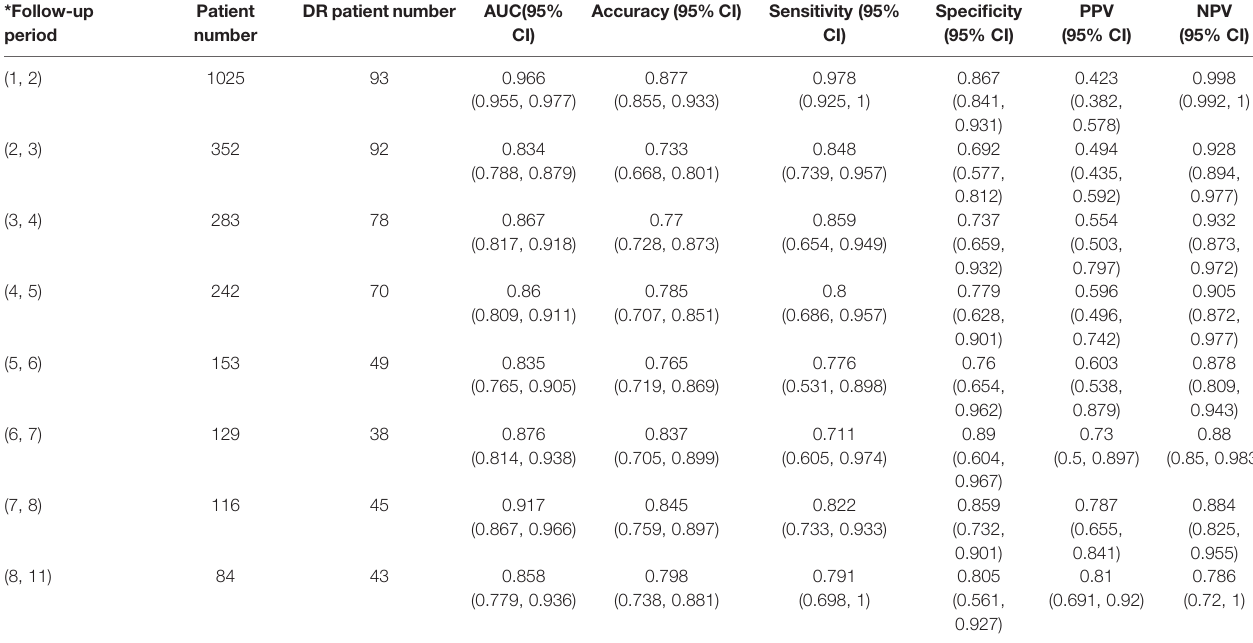
TABLE 2 | The performance metrics of the XGBoost model for different follow-up